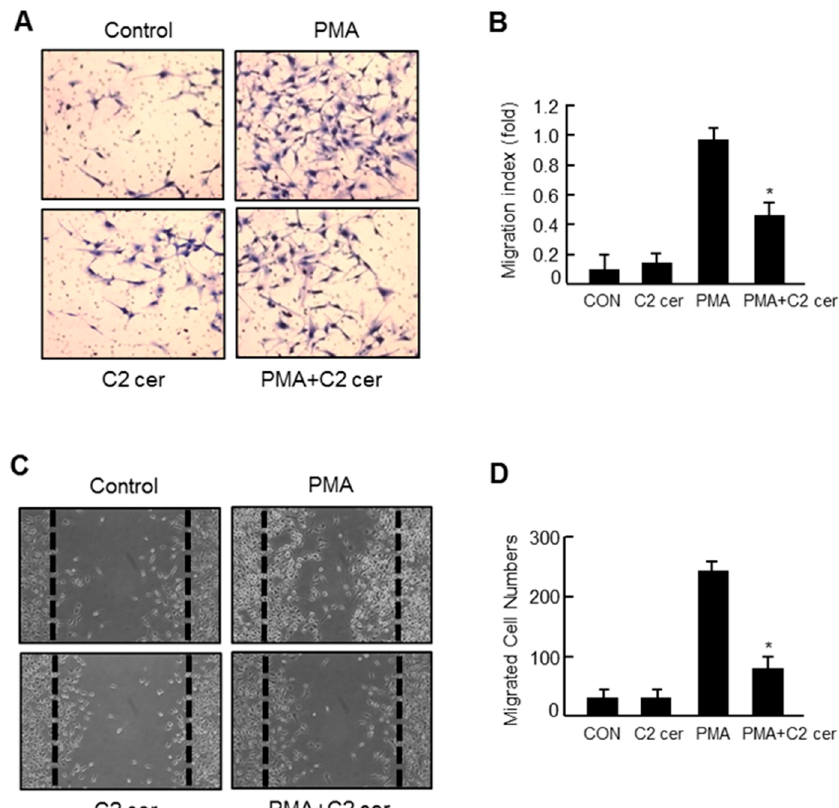
Figure 3. C2 ceramide inhibits the in vitro invasion and migration of U87MG glioma cells. ( A ) The effect of C2 ceramide (25 μ M) on the invasion of U87MG cells was determined using the modified Boyden chamber method, as described in the Methods section. Cells were treated with C2 ceramide for 1 h before stimulation with PMA (50 ng/mL) for 24 h. Cells that invaded the lower surface of the membrane were fixed and stained; ( B ) cells were counted from at least 10 fields; data represent the mean ± S.E.M. of at least three independent experiments. * p < 0.05; significantly different from the PMA-treated sample; ( C ) the effect of C2 ceramide (25 μ M) on the migration of U87MG cells was observed by wound healing assay as described in the Methods section; and ( D ) migratory cells were counted from four phase images at each point and then averaged for each experimental condition. N = 3, * p < 0.05; significantly different from the PMA-treated sample.